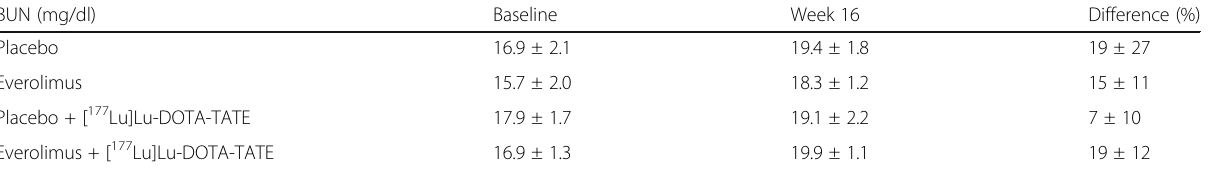
Table 2 Mean BUN at baseline, week 16 and corresponding differences with confidence intervals BUN (mg/dl)